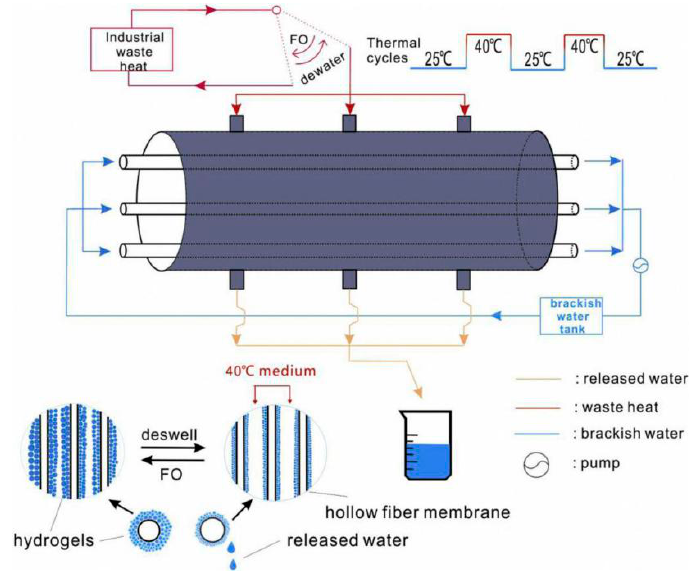
Figure 6. Quasi-continuous forward osmosis (FO) desalination using a semi-interpenetrating network (IPN) hydrogel as the draw agent. Reprinted from Reference [43] with permission from Elsevier.